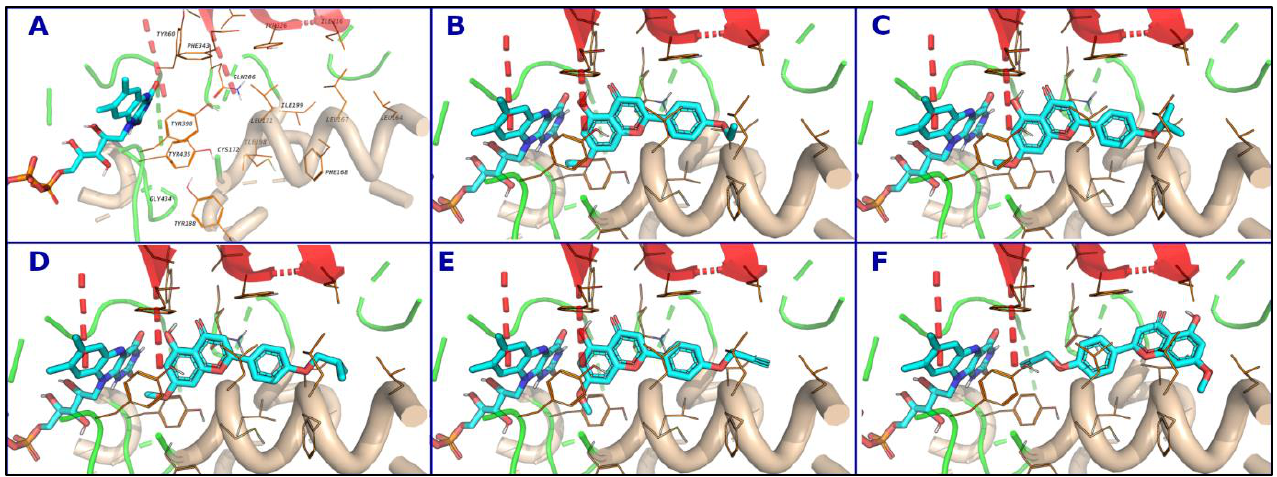
Figure 9. Binding modes of acacetin 7- O -methyl ether derivatives and surrounding amino acids. The amino acids that interact with the ligand are shown as lines ( A ), Compounds 1c ( B ), 2c ( C ), 3c ( D ), and 4c ( E , F ). There are two possible orientations for 4c in the binding site.